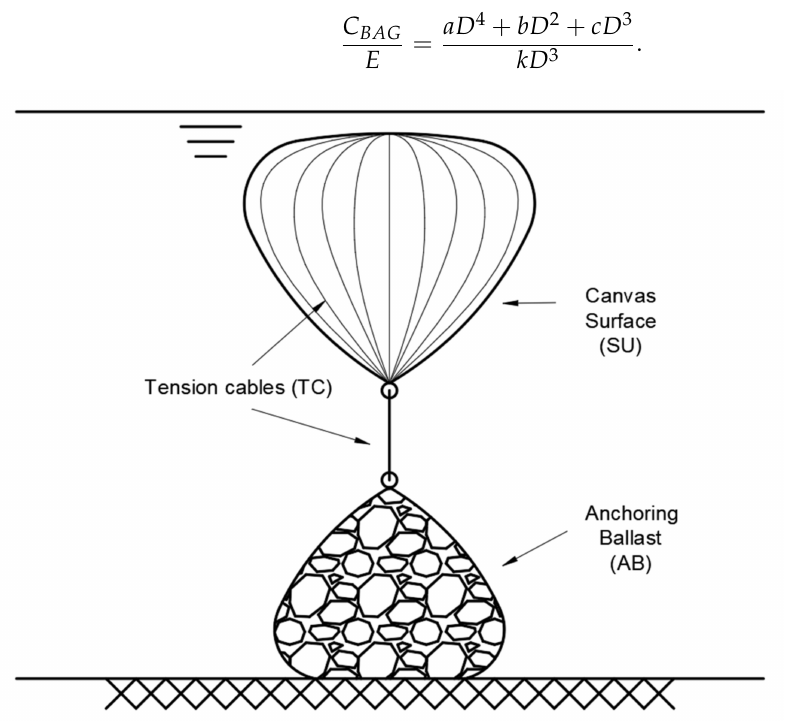
Figure 3. Energy bag underwater compressed air energy storage (UWCAES) system. Shown without pipework for